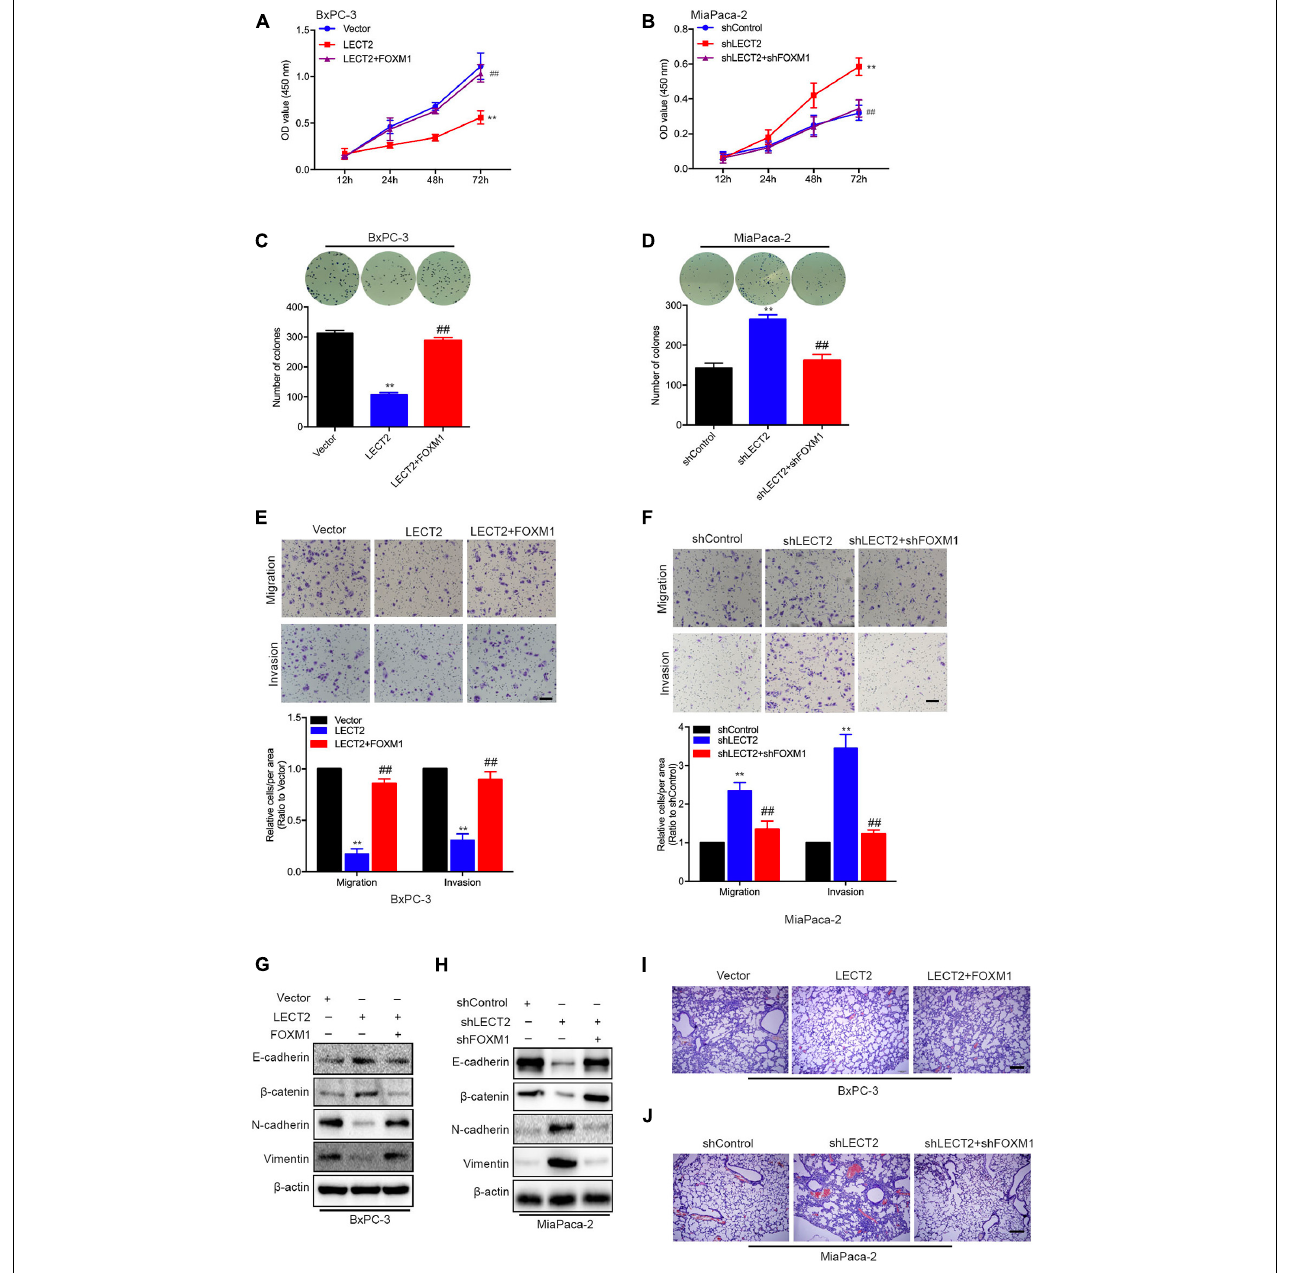
FIGURE 7 | LECT2 suppresses malignant behaviors depending on FOXM1. (A) Cell proliferation of BxPC-3 cells transfected with control (blue), LECT2 (red), or LECT2 together with FOXM1 (magenta) vectors. (B) Cell proliferation of MiaPaca-2 cells transfected with shControl (blue), shLECT2 (red), or shLECT2 together with shFOXM1 (magenta) vectors. (C,D) Colony formation of BxPC-3 (C) and MiaPaca-2 (D) cells as described in (A,B) . (E,F) Migration (top) and invasion (middle) of BxPC-3 (E) and MiaPaca-2 (F) cells as described above with corresponding quantifications (bottom). (G,H) Immunoblotting analysis of E-cadherin, β -catenin, N-cadherin, and Vimentin protein levels in BxPC-3 (G) and MiaPaca-2 (H) cells as described above. (I,J) Representative H&E staining images of metastatic lung foci per section from allograft mice injected with BxPC-3 (I) and MiaPaca-2 (J) cells as described above. Scale bar = 50 µ m in (E,F) . Scale bar = 200 µ m in (I,J) . ** p < 0 . 01 and ## p < 0 .